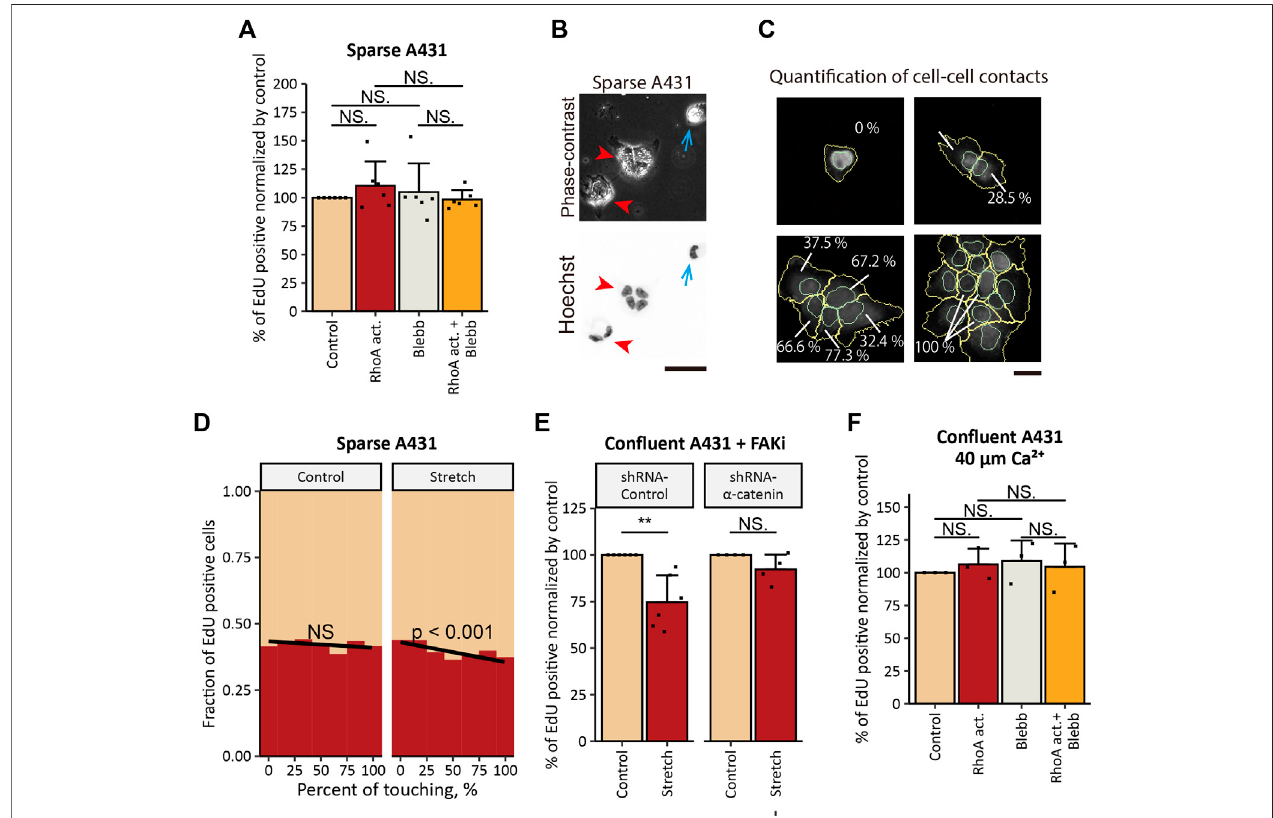
FIGURE 5 | Tensile loading-induced inhibition of the proliferation depends on the intact AJs in cSCC cells. (A) Ratios of EdU-positive nuclei in sparse A431 cells treated with 5 μ g/ml RhoA activator (RhoA act.), 100 μ M p -aminoblebbistatin (Blebb) or combination of both drugs (RhoA act. + Blebb) for 6 h followed by incubation with EdU for 2 h in the presence of the same compounds. Sequestered cells lacking any cell-cell contact were used for the analyses. Values were normalized with the mean value in control cells. Each bar represents mean ± SD. n (cid:1) 6 independent experiments ( > 900 cells each). NS, p > 0.05. (B) Phase-contrast and fl uorescence images of A431 cells seeded at a low cell density. Cell nuclei were labeled with Hoechst 33342. Blue arrows indicate sequestered cell, and red arrowheads indicate cell clusters. Scale bar, 50 μ m. (C) Graphical representation of the quanti fi cation of cell-cell contact. In cells stained for nuclei (with Hoechst 33342) and β -catenin, nuclei (cyan) and whole-cells (yellow) were outlined, and the percentage of the cell perimeter contacting to neighboring cells was quanti fi ed using CellPro fi ler software. Scale bar, 50 μ m. (D) Under 20% UPS (Stretch, right panel ), but not under the static condition (Control, left panel ), the fraction of A431 cells that transited into S-phase decreased withthe increase inthe percentage ofthecell perimeter that wasindirect contact with neighboring cells. Results oflogisticregression fi ttingarepresentedas black lines with the corresponding p -values (NS, p > 0.05). Results of four independent experiments ( > 800 cells each) were pooled for the analysis. (E) Ratios of EdU- positive nuclei in FAKi-treated A431 cells expressing control-shRNA or α -catenin-shRNA under static (Control) and 20% UPS (Stretch) conditions. Values were normalized withthe mean values in static controls. Each bar represents mean ± SD. n ≥ 4 independent experiments. ** p < 0.01; NS, p > 0.05. (F) Ratios ofEdU-positive nucleiincon fl uentA431cellstreatedasin (A) underthelow-Ca 2+ condition.Valueswerenormalizedwiththemeanvalueincontrolcells.Eachbarrepresentsmean ± SD. n (cid:1) 3 independent experiments. NS, p >